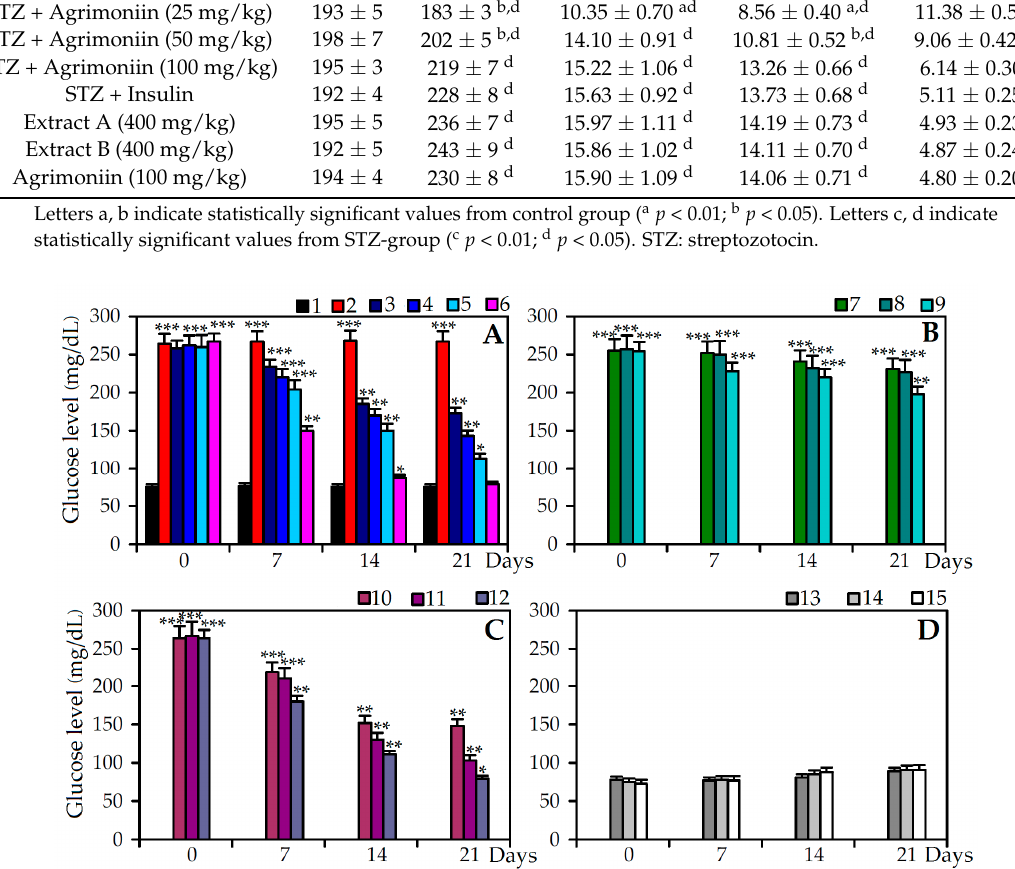
Figure 4. Fasting blood glucose level response in diabetic (STZ) and non-diabetic rats. ( A ) 1 . Control; 2 . STZ + saline; 3 . STZ + Extract A (100 mg/kg); 4 . STZ + Extract A (200 mg/kg); 5 . STZ + Extract A